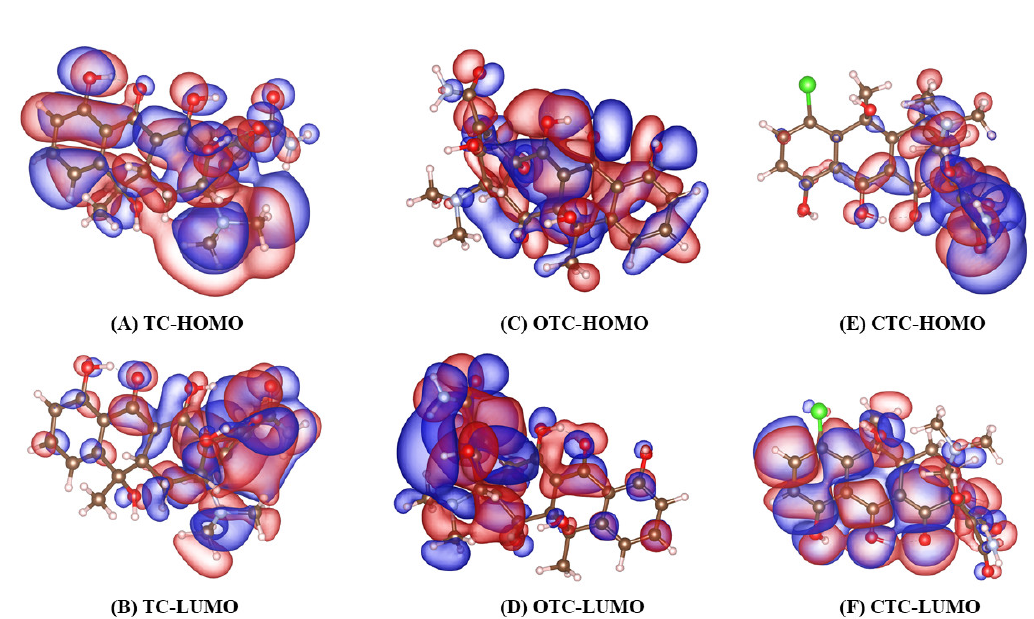
Figure 4. HOMOs and LUMOs of TC, OTC, and CTC.